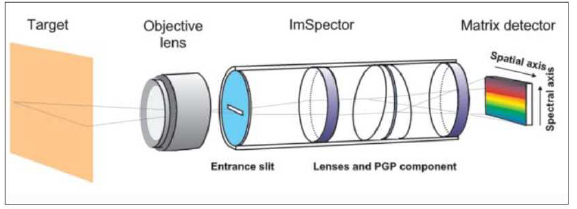
Figure 2: Schematic of the imaging spectrograph